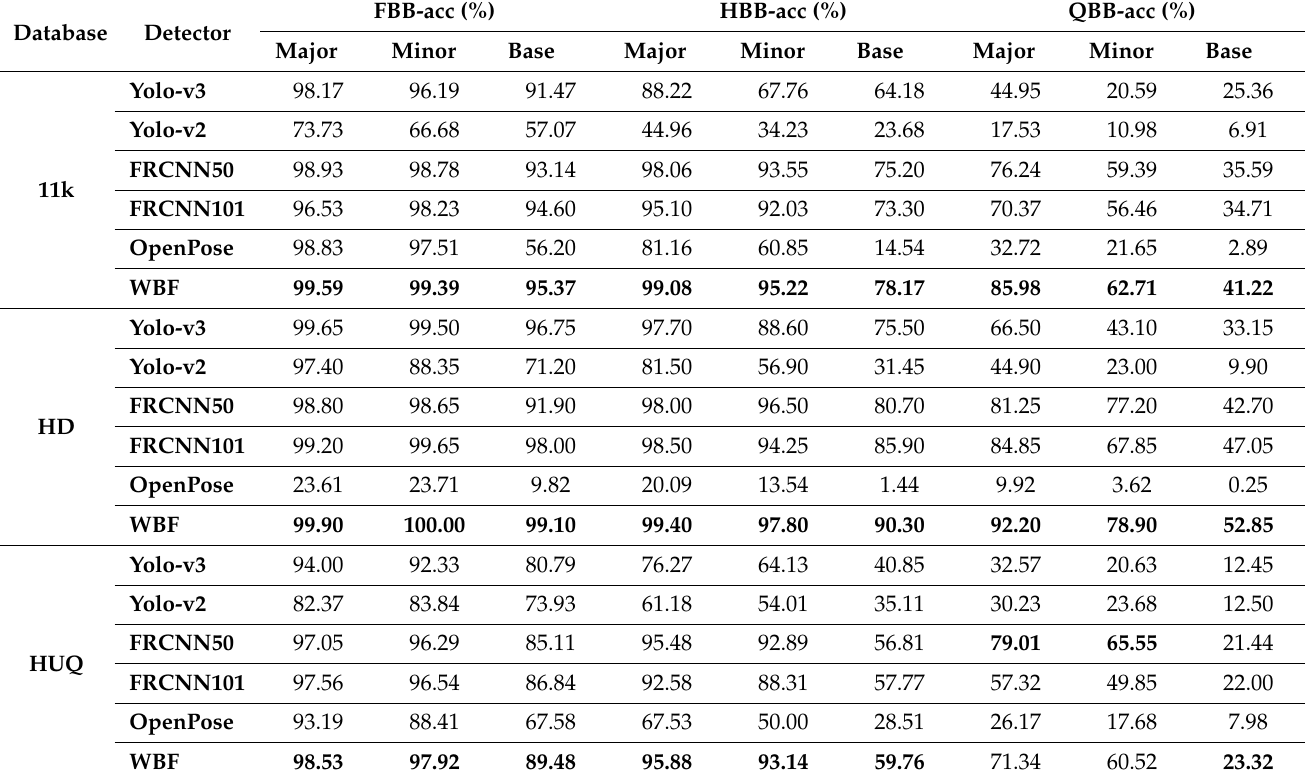
Table 3. Point-form comparison of different